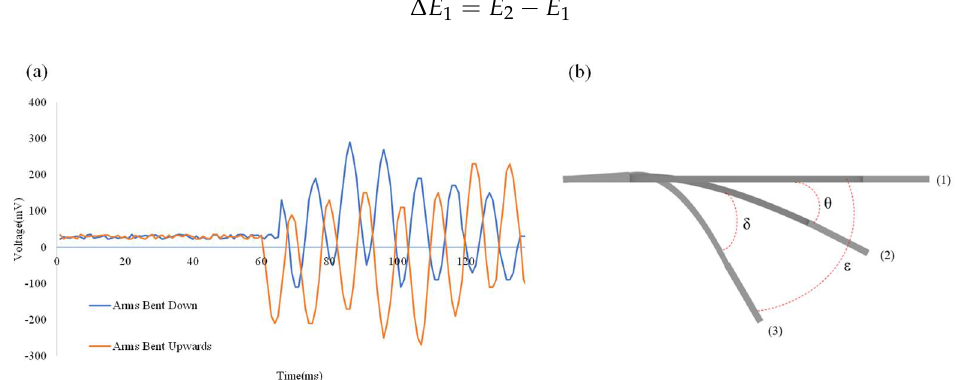
Figure 9. ( a ) Installation of the sensor on the robotic arm, with blue signal for arm down and orange for arm up; ( b ) bending diagram of piezoelectric strain sensor. (1) Initial position of the sensor. (2) With the sensor position of (1) as the zero plane, bending downward θ. (3) With the sensor position